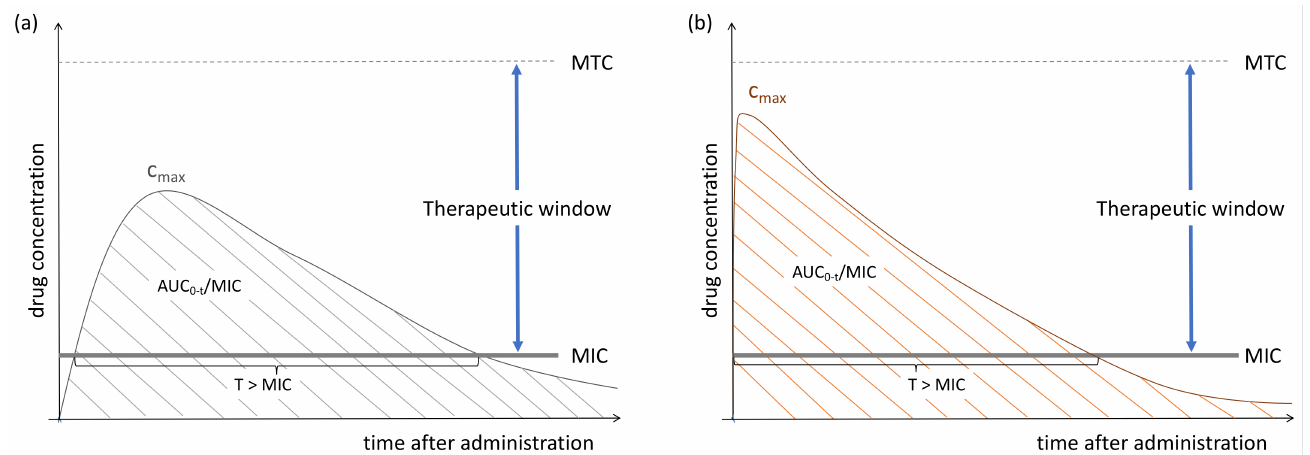
Figure 2. Concentration-time curve following oral administration or prolonged infusion ( a ) and after intravenous administration ( b ). Abbreviations: AUC 0-t4 : area under the curve between dosing interval. C max : maximum concentration. T: time. MIC: minimum inhibitory concentration. MTC: minimum toxic